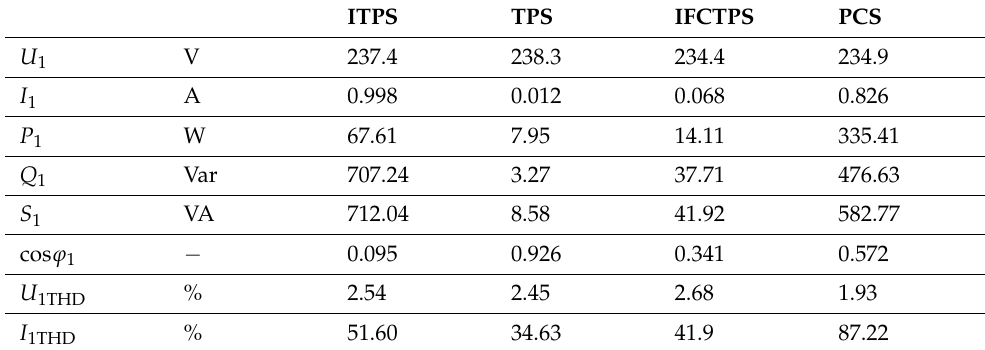
Table 4. Operating parameters of power supplies in no-load condition.